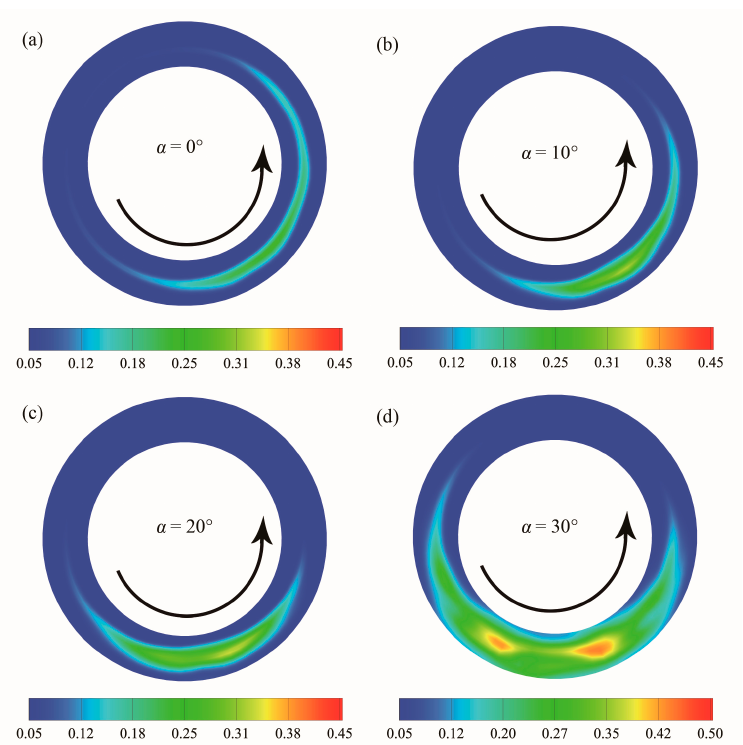
Figure 9. Contours of the cuttings volume fraction of different blade angle: ( a ) α = 0°; ( b ) α = 10°; ( c ) α = 20°; ( d ) α = 30°.